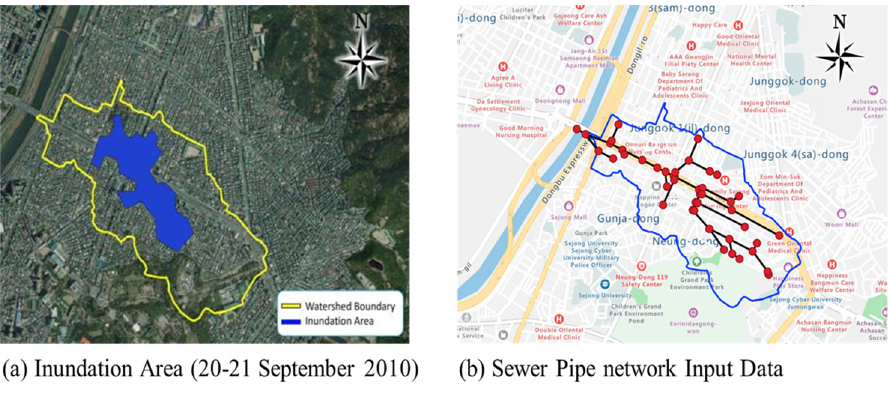
Figure 11. GIS map of the Gunja watershed.